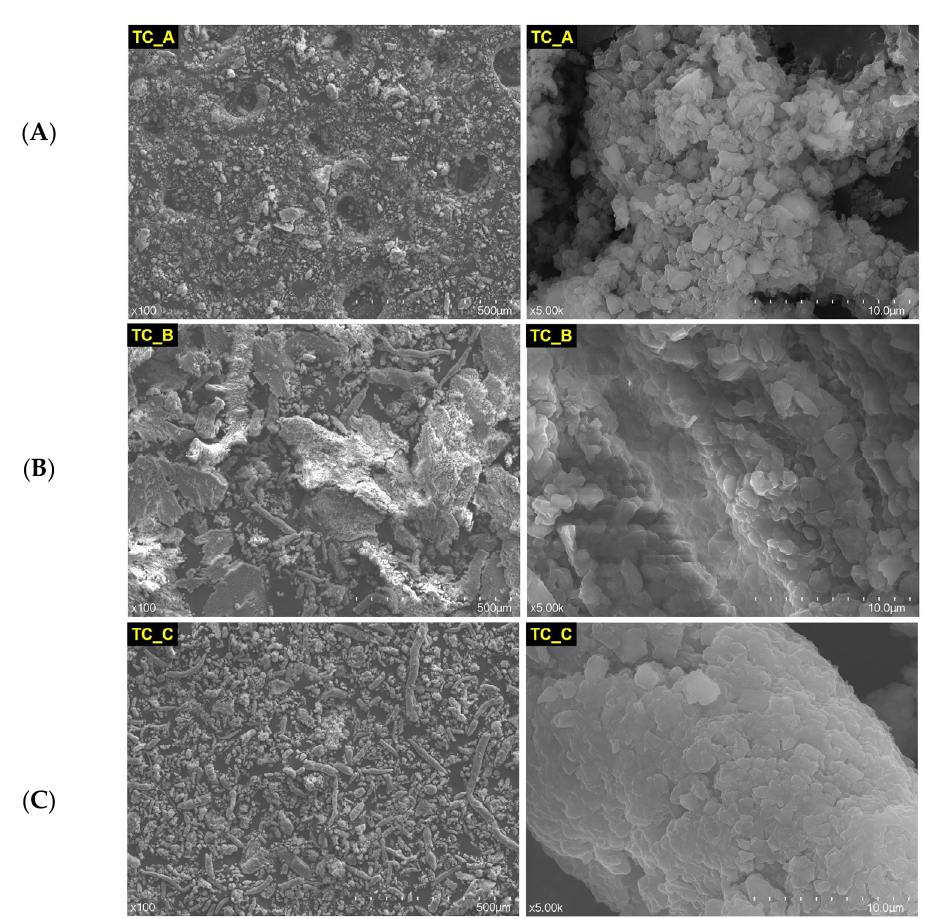
Figure 4. SEM images of TC restorative material powder, nonexposed ( A ) and exposed (rough ( B ) and fine ( C )) to acidic artificial saliva.